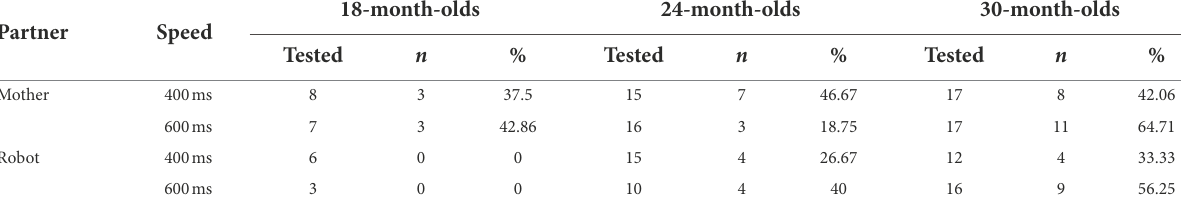
TABLE 1 Absolute number and percentage of children reaching significance in Rayleigh’s test.